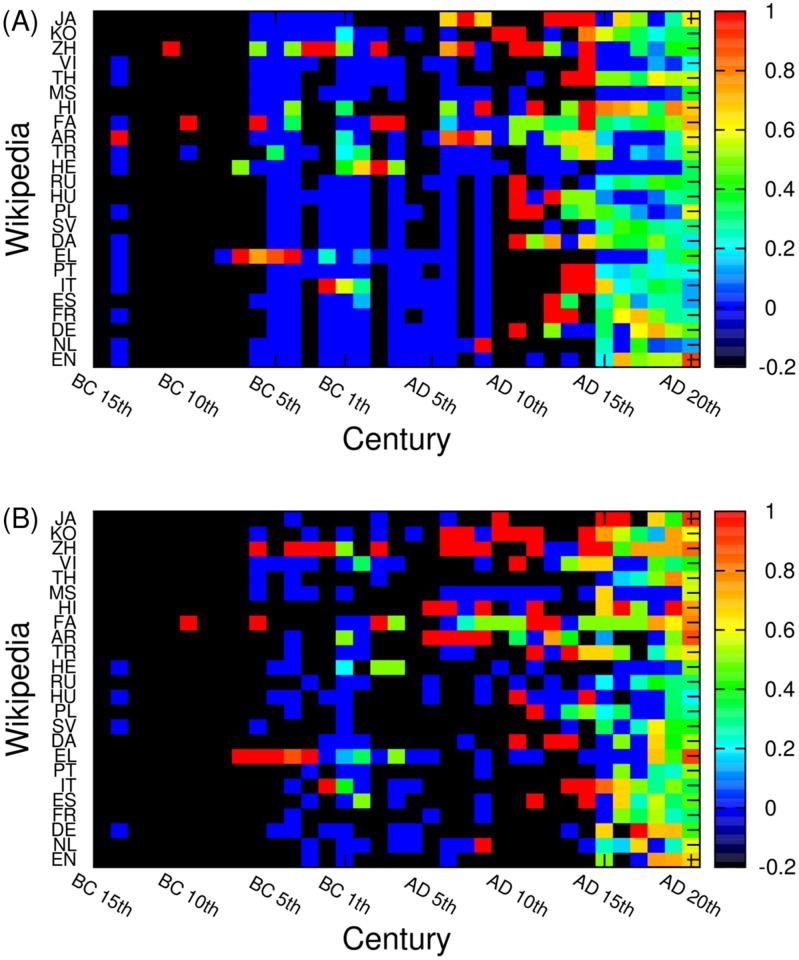
The locality property of cultures represented by the ratio r
L, C = M
L, C/N
L, C for each edition L and each century C.Here M
L, C is the number of historical figures born in countries attributed to a given language edition L at century C and N
L, C is the total number of historical figures in a given edition at a given century, regardless of language of their birth countries. Black color (-0.2 in the color bars) shows that there is no historical figure at all for a given edition and century; blue (0 in the color bars) shows there there are some historical figures but no same language historical figures. Here (A) panel shows PageRank historical figures, and (B) panel shows 2DRank historical figures.